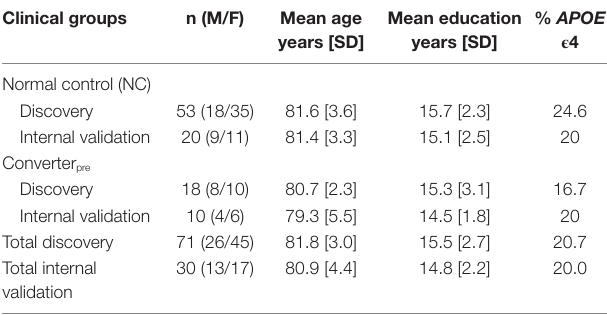
TaBle 1 | Discovery and internal validation cohort demographic details. clinical groups